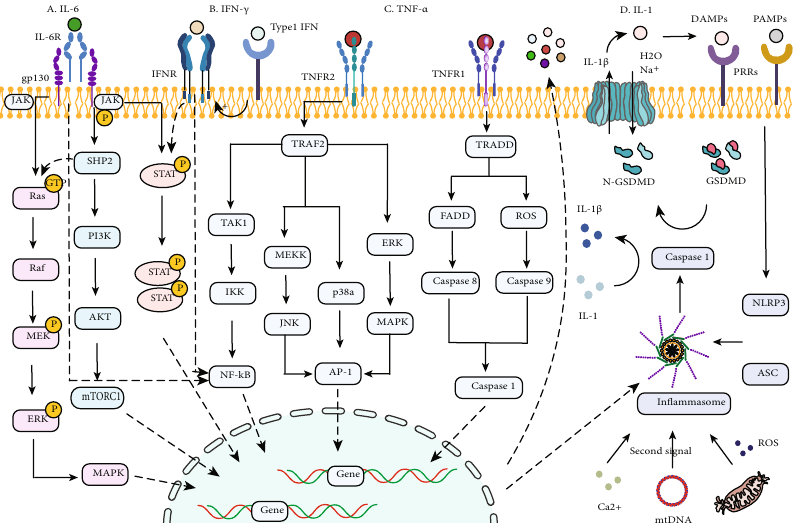
Figure 2: Cytokine signaling pathway activated by IL-6, TNF- α , IFN- γ , IL-1, and the in fl ammasome. (a) IL-6 mainly mediates signal transduction through Ras-Raf-ERK-MAPK, NF- κ B, JAK/STAT3, and PI3K-Akt-mTOR. (b) IFN- γ activates the downstream pathway through JAK/STAT1 and NF- κ B to generate a cascade ampli fi cation e ff ect. (c) TNF- α promotes in fl ammatory response di ff usion through NF- κ B activation (activated by the sequential recruitment of TRAF2, RIP, TAK1, and IKK) and induces apoptosis by activation of AP-1 and caspase-3. After recruitment of TRAF2 and RIP, AP-1 can be activated through three pathways, in which the following key molecules are involved: ① MEKK and JNK, ② P38a, and ③ ERK and MAPK. Caspase-3 levels can be elevated by sequential recruitment of TRADD, FADD, and caspase-8 or via TRADD, ROS, and caspase-9. (d) IL-1 decomposes into IL-1 α and IL-1 β under in fl ammasome activation, and then, IL-1 β is released through Gasdermin D (GSDMD) lysate pore and induces cell swelling and apoptosis. The fi rst and second signals are necessary for activation of the in fl ammasome. JAK: Janus kinase; STAT: the signal transducer and activator of transcription; Ras: a GTPase; Raf: Raf kinase; ERK: extracellular signal-regulated kinase; MAPK: mitogen-activated protein kinase; MEK: MAPK/ERK kinase; SHP2: Src homology 2-containing protein tyrosine phosphatase 2; PI3K: phosphatidylinositol 3 kinase; AKT: